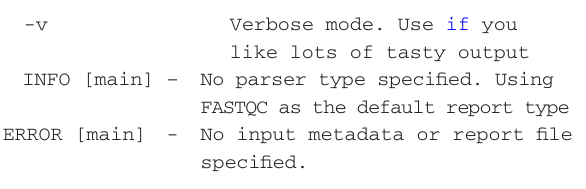
Table 1. Example fields in an analysis metadata table